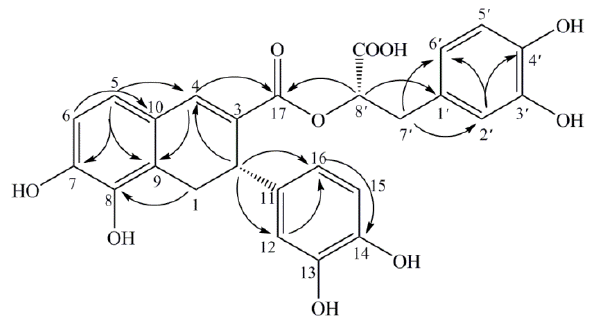
Figure 4. Key HMBC correlations (H → C) in compound 2